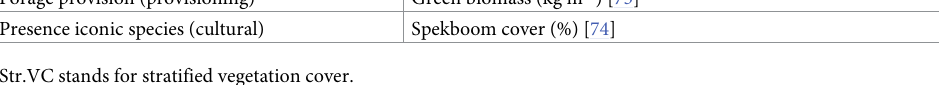
Table 1. Selected ecosystem services and indicators used to describe their variability. Ecosystem service Ecosystem service indicator Erosion prevention (regulating) Stratified vegetation cover index (% Str.VC) [72] Forage provision (provisioning) Green biomass (kg m -2 ) [73] Presence iconic species (cultural) Spekboom cover (%) [74] Str.VC stands for stratified vegetation